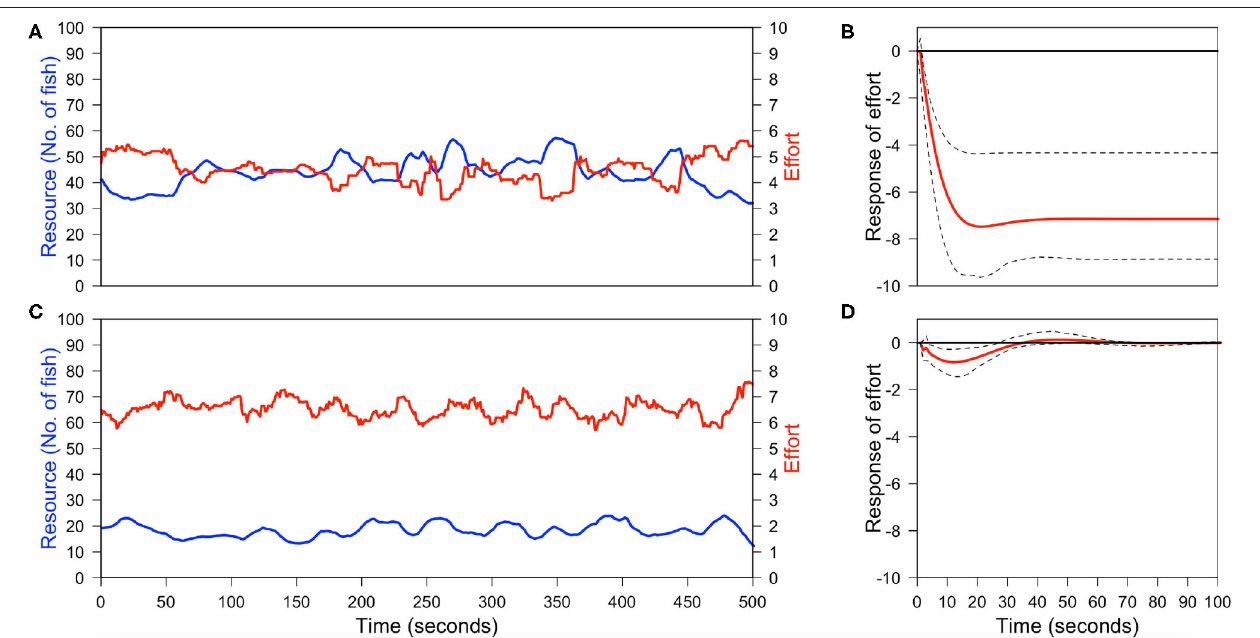
FIGURE 1 | Summary of results. Time-series of resource and effort levels obtained with the CPR experiments under (A) communication and (C) no communication. Resource and effort blue and red lines, respectively, in (A,C) are averages of the three experimental sessions we run for each treatment, see Table 2 . The carrying capacity is set to 100 fishes in all sessions. Impulse response analysis showing responses of effort to changes in resource levels for (B) communication and (D) no communication (red lines). The dashed lines represent the 95 % confidence intervals and the continuous horizontal lines mark the zero.